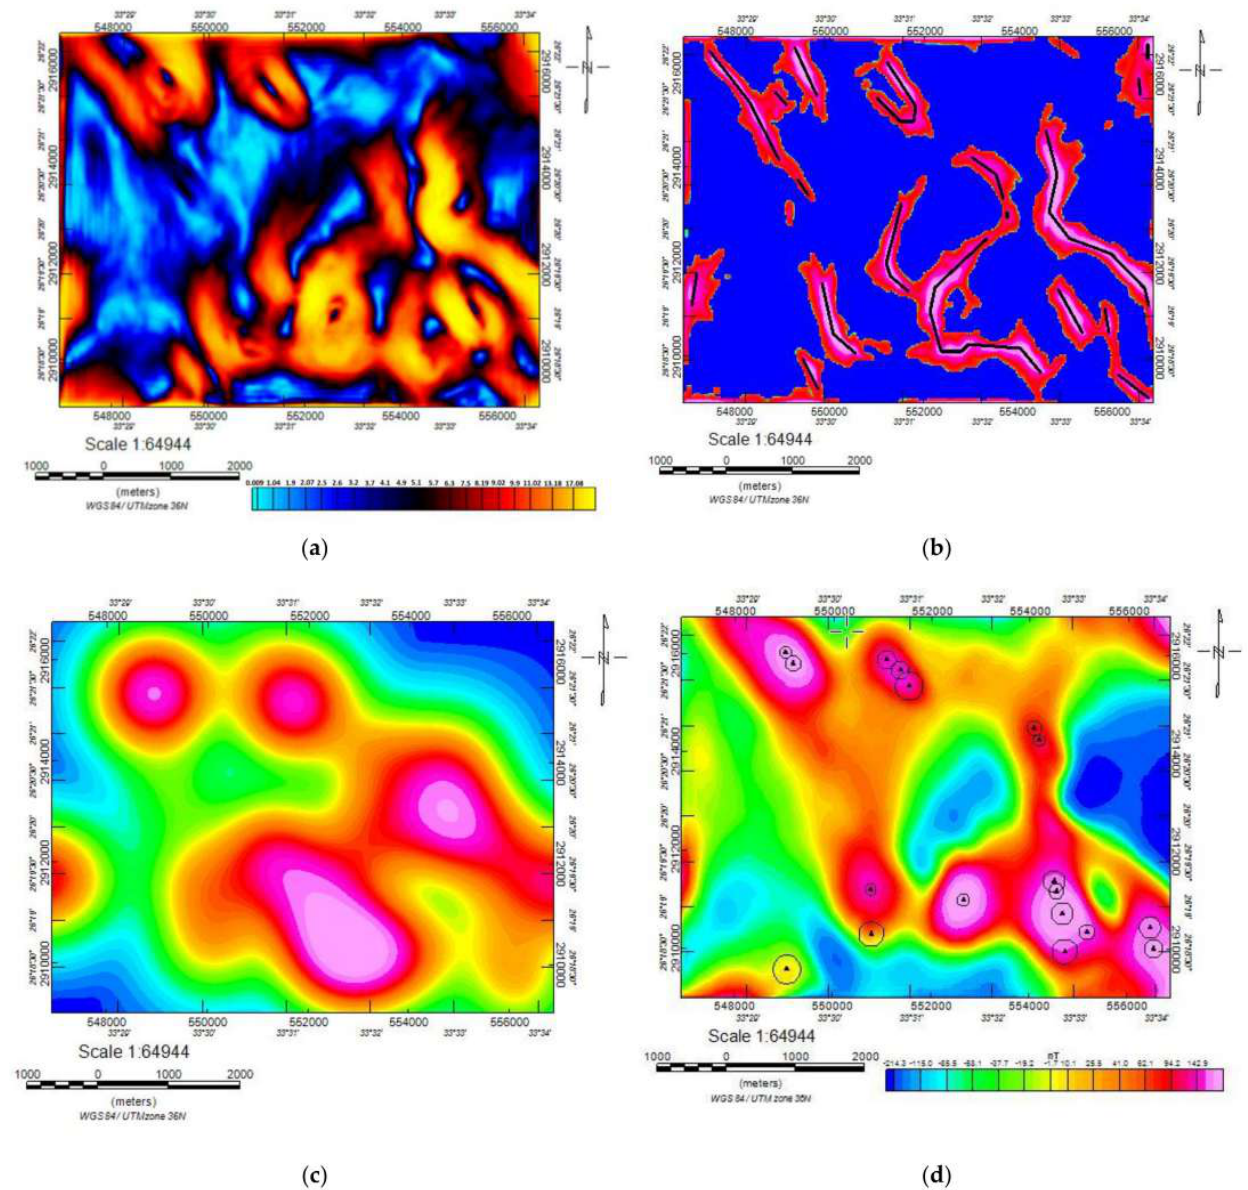
Figure 11. ( a ) Standard-deviation map. ( b ) Phase symmetry map; the black lines are the faults inferred by the CET approach. ( c ) Figure illustrating the OE map. ( d ) The circular-boundary porphyry tracing (black circles and triangles) is overlaid on the RTP map of the research